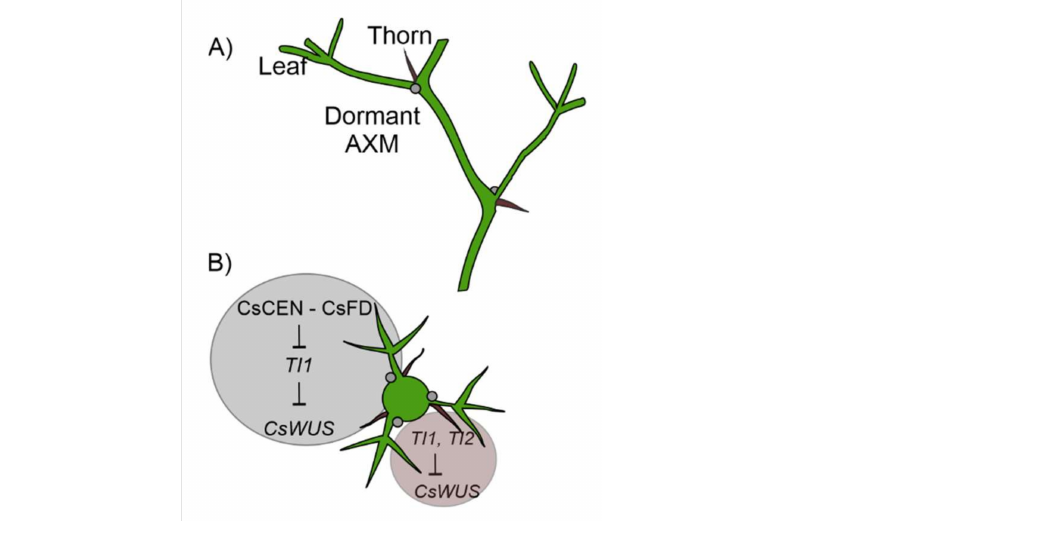
Figure 4. Regulation of plant architecture in Citrus . ( A ) Citrus growth habit showing two leaves accompanied by a thorn and a dormant axillary meristem (AXM) at the leaf axil. ( B ) Genetic network regulating AXM fate in Citrus . AXMs loose CsWUS activity and develop into determinate thorns when TI1 and TI2 repress CsWUS in thorn meristems. AXMs remain in an undifferentiated, dormant state when the protein complex formed by CsCEN and CsFD represses TI1 , resulting in CsWUS activity and maintenance of stem cell proliferation. Dormant AXBs are depicted by filled gray